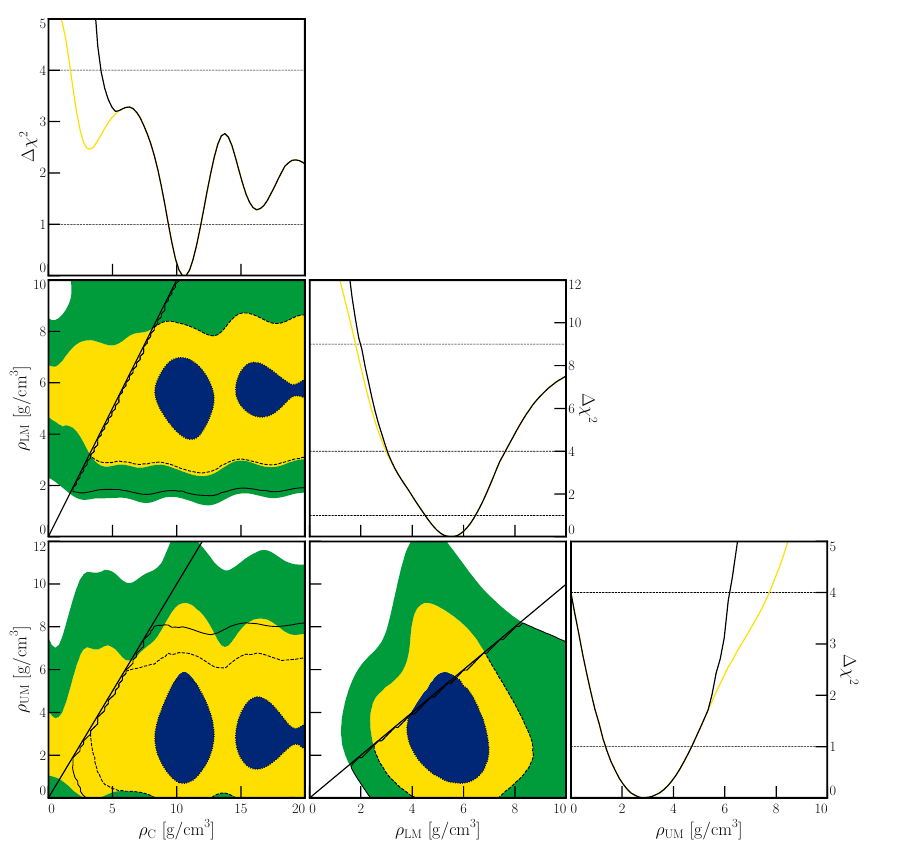
Figure 18 . DUNE’s sensitivity to the core, lower mantle and upper mantle densities without considering constraints from total Earth mass and moment of inertia measurements. The colored areas correspond to 1 σ (blue), 2 σ (yellow), and 3 σ (green) allowed regions for 2 degrees of freedom, that is ∆ χ 2 = 2 . 3 , 6 . 2 , 11 . 8 , respectively. The solid black lines correspond to 1 σ (dotted), 2 σ (dashed), and 3 σ (solid) allowed regions when the hydrostatic equilibrium condition is also imposed. In the diagonal, one-dimensional ∆ χ 2 plots, the solid lines indicate DUNE sensitivity after marginalizing over the other two layers — yellow (black) lines are the sensitivity without (with) imposing the hydrostatic equilibrium